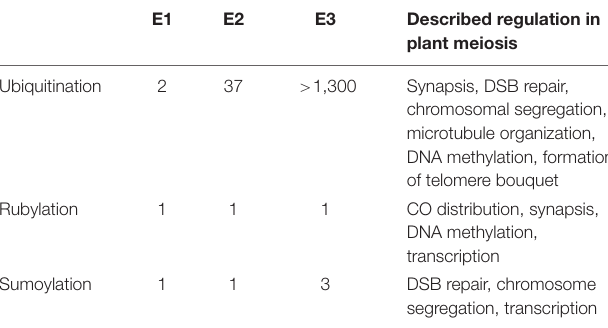
TABLE 1 | Comparison of the number of identified E1, E2, and E3 enzymes in the ubiquitination, rubylation, and sumoylation cascade in Arabidopsis and processes they are known to regulate in